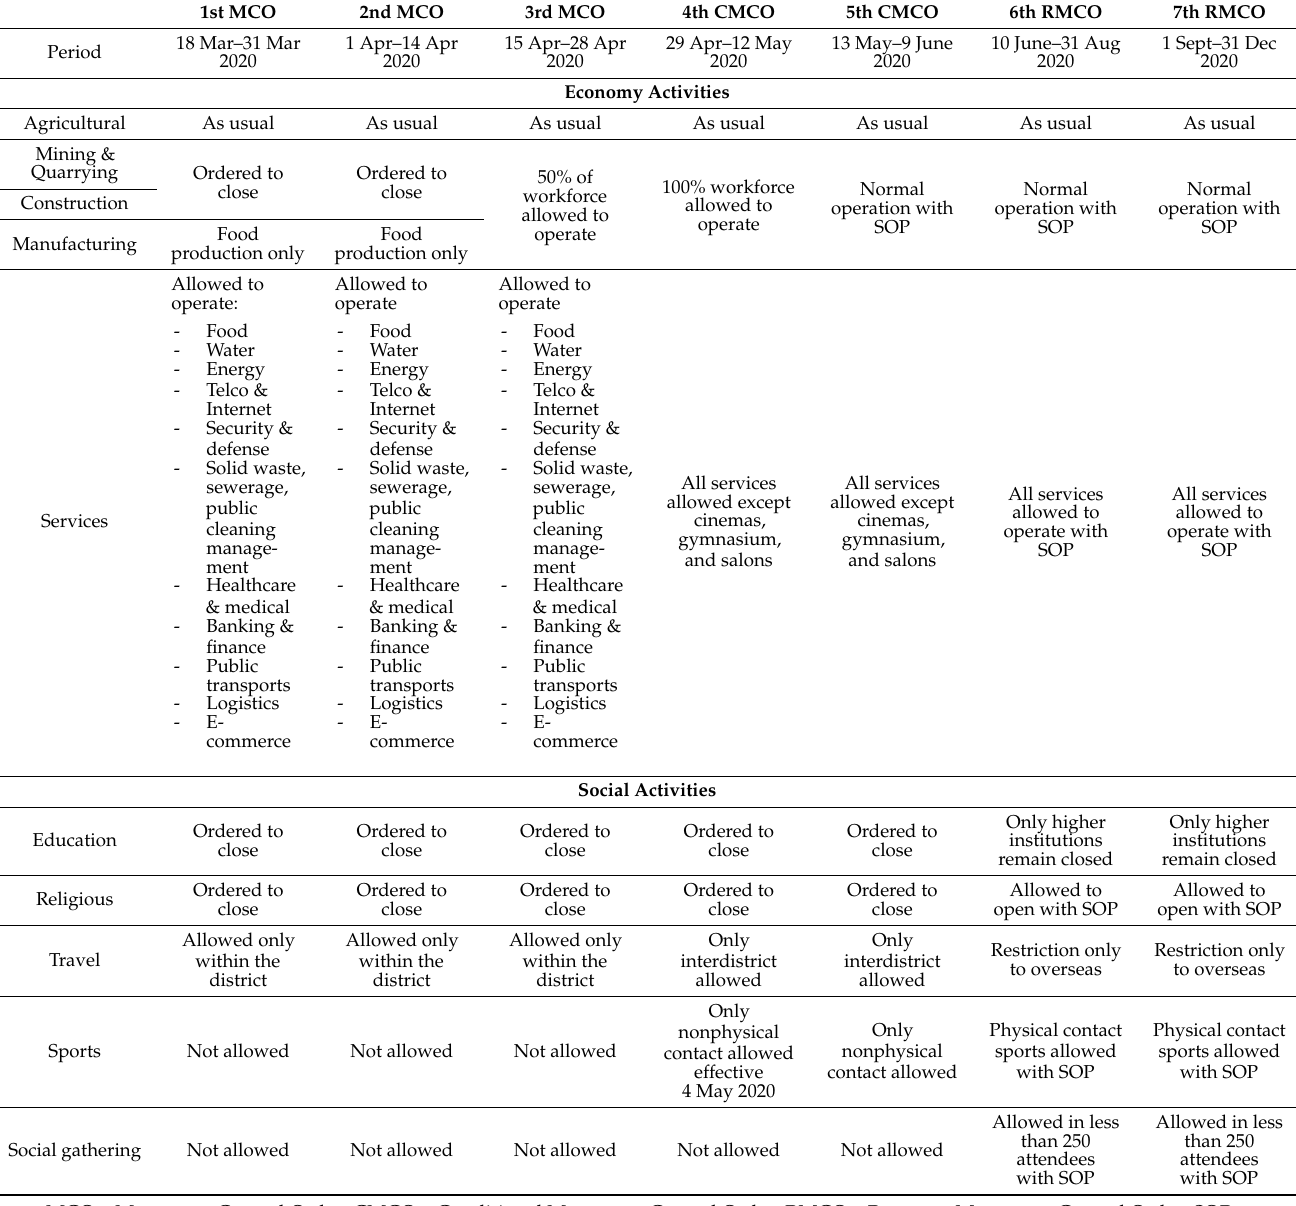
Table 1. The phases of the movement control order (MCO) in